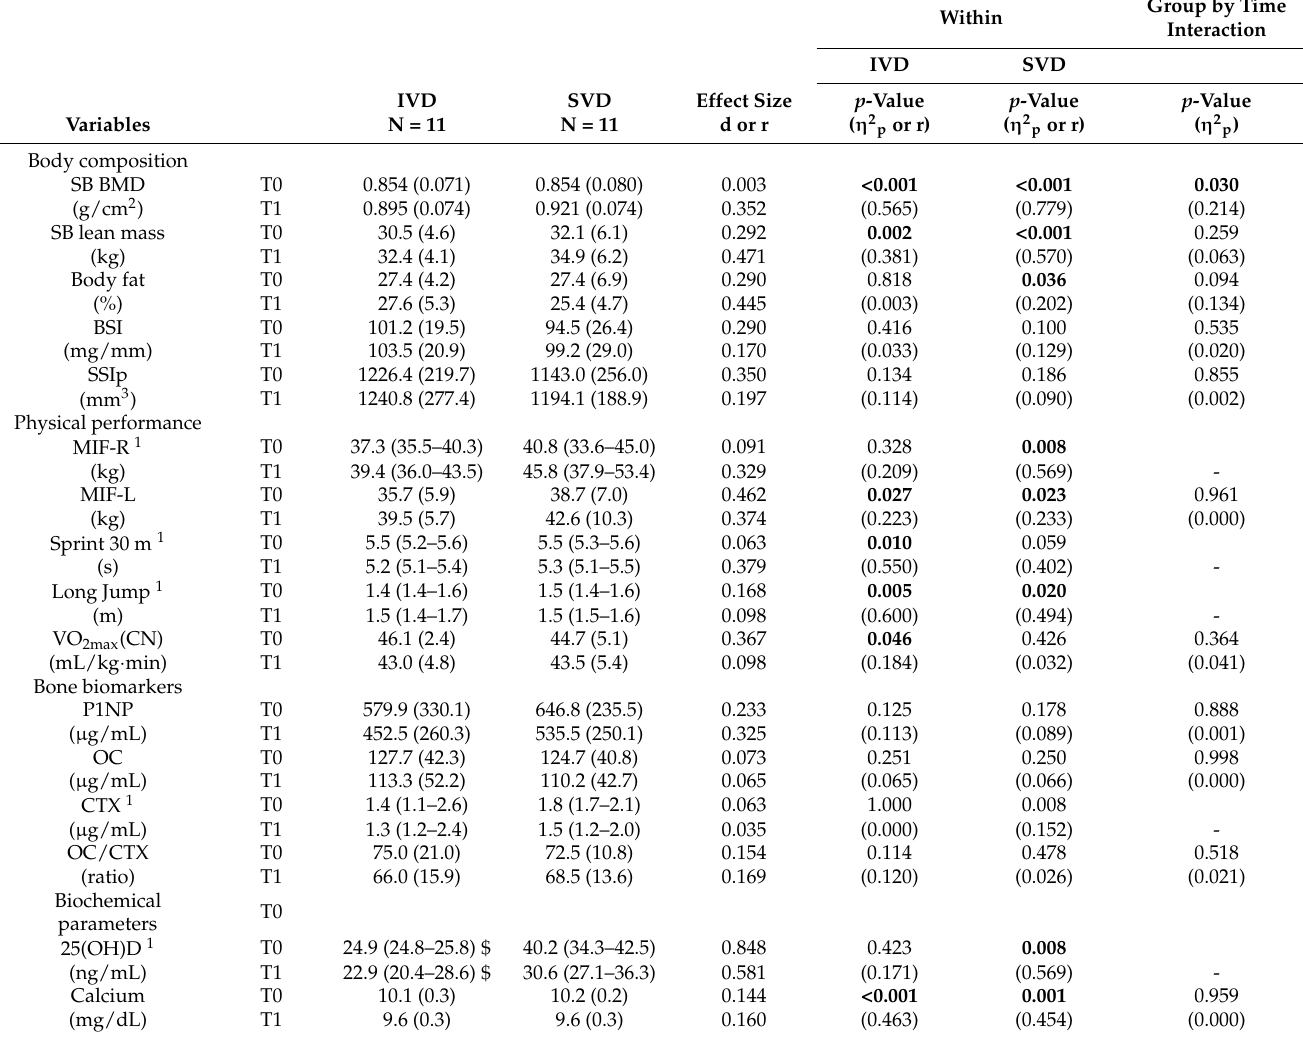
Table 2. Body composition, physical performance, bone biomarkers and blood biochemical parame- ters of female football players with different 25(OH)D